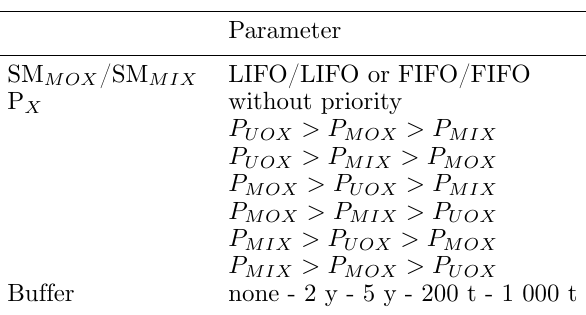
Table 7. Sampled variables for buffer